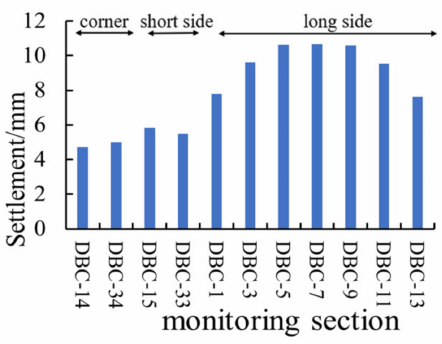
Figure 8. Maximum ground settlement.